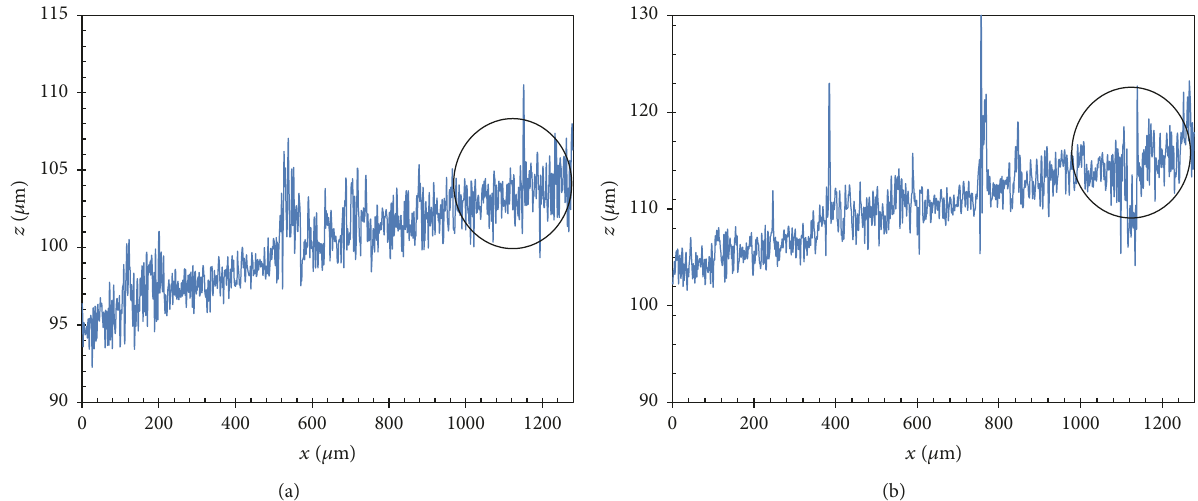
Figure 8: Transverse profiles obtained from the CLSM micrographs of the AZ91D alloy: (a) the as-received condition; (b) after immersion for 15h in 3.5 wt.% NaCl solution at room temperature.